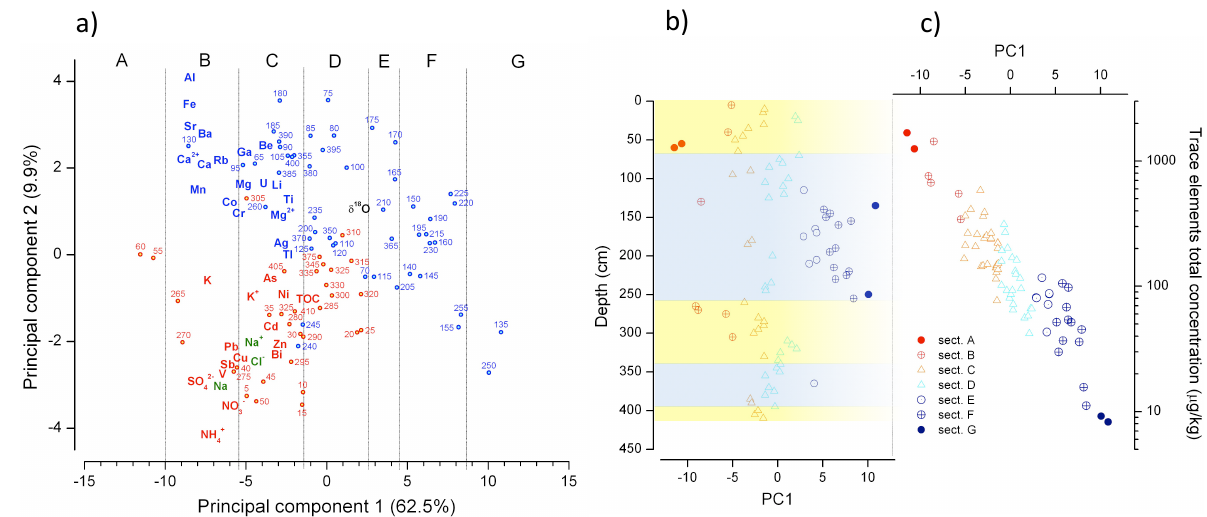
Fig. 3. Principal Component Analysis (PCA) biplot (panel (a) ) of all the chemical variables (variable name) and cases (points indicating the depth, in cm, of the corresponding sample) on the first two principal components which explain 62.5% and 9.9% of the total variance, respectively. The red-written cases correspond to the samples from warm periods while the black those from cold periods, as inferred from the stratigraphic observations. In panel (b) , we show the seasonal distribution (red and blue bands are warm and cold periods, respectively) as reconstructed from the depth profiles (in Fig. 2) of negative and positive PC1 loadings (sectors A, B and E, F, G, respectively). In panel (c) , we show the relation between PC1 and the trace element